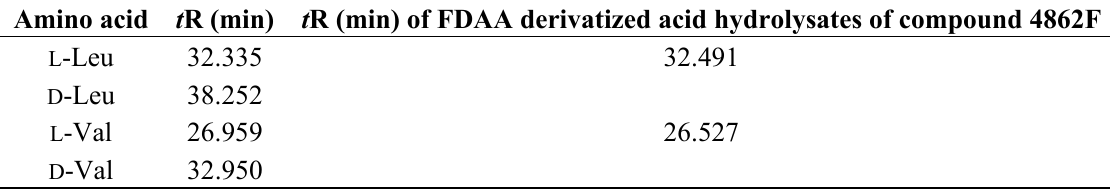
Table 2. HPLC Analysis of FDAA Derivatized Acid Hydrolysates of Compound 4862F. Amino